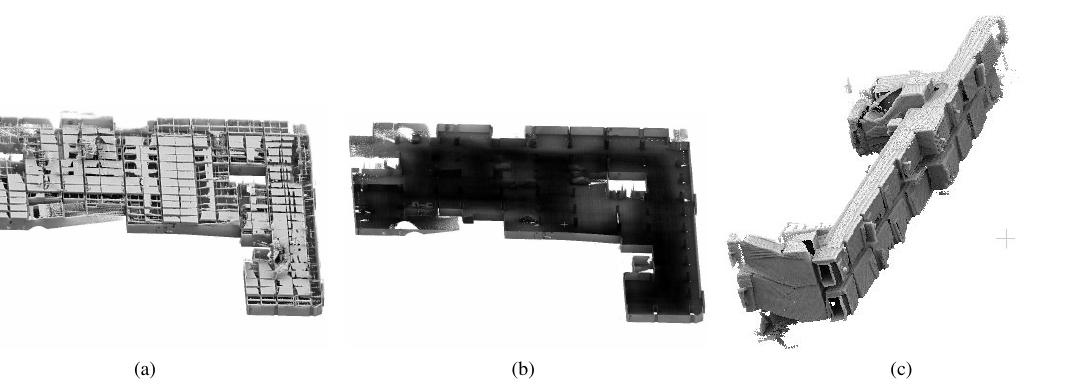
Figure 4. Experimental scenes. (a) Scene 1: underground garage. (b) The internal scene of the underground garage. (c) Scene 2:Two-story corridor.